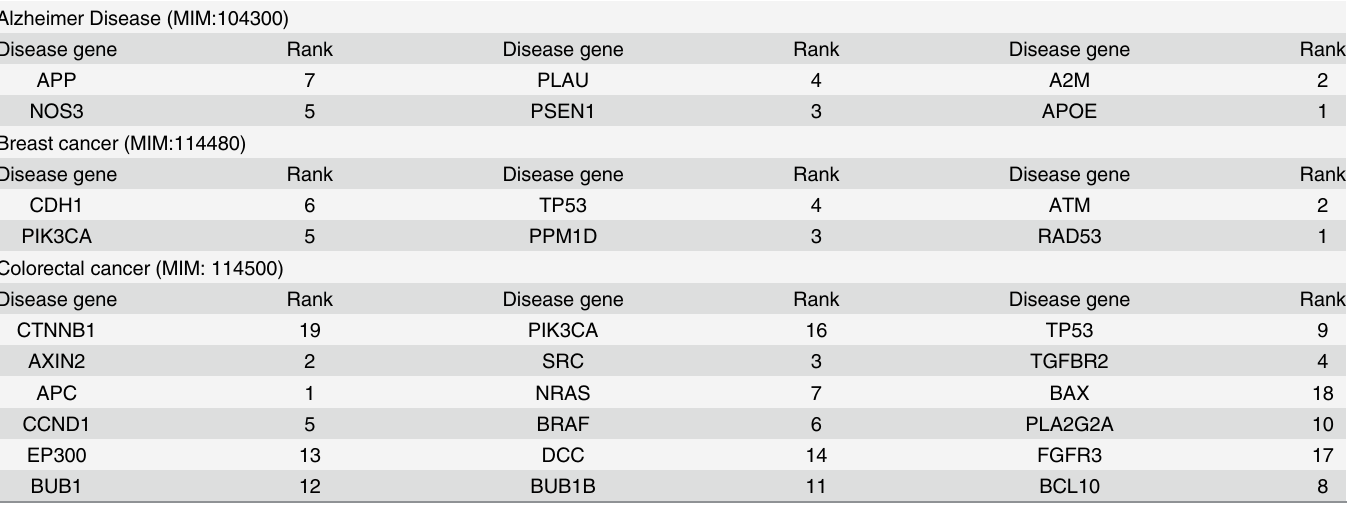
Table 2. The ranks of known disease genes for three instances. Alzheimer Disease (MIM:104300) Disease